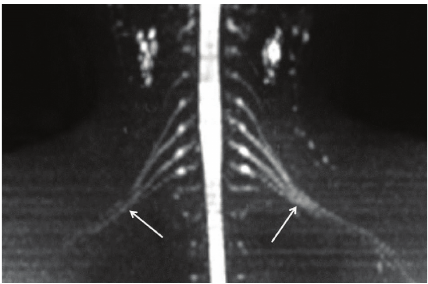
Figure 5: 3D anatomic nerve selective MRN-Coronal MIP from a 3D diffusion weighted single shot EPI ( 𝑏 value 800 s/mm 2 ) shows the symmetrical normal appearance of bilateral brachial plexuses (arrows).